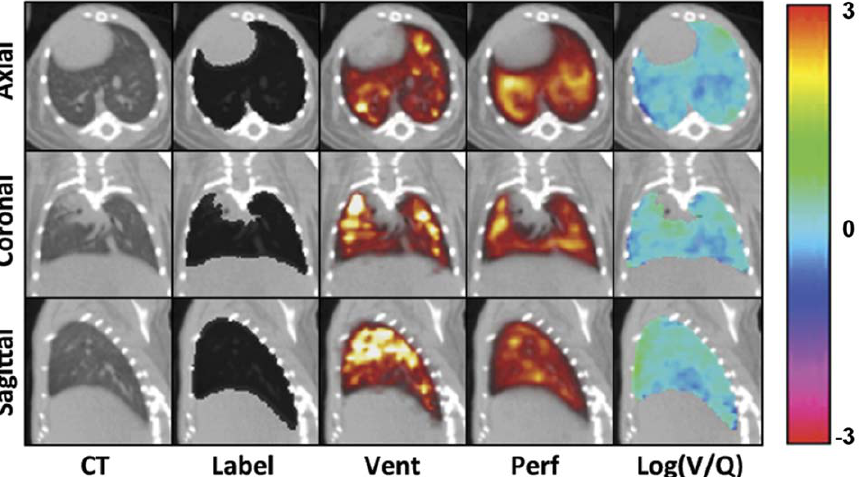
Figure 2. Representative CT and SPECT slice images in axial, coronal, and sagittal planes. The animal shown was chosen based on average mean and standard deviation values for the data set. CT refers to the ventilation-associated CT. Label refers to the lung segmentation seen as a black overlay on the CT. Vent and Perf refer to V and Q images with the colour scale increasing from red through yellow to white for both. Log(V/Q) refers to the final calculated data and the colour bar indicates the values seen in the associated log(V/Q) images.